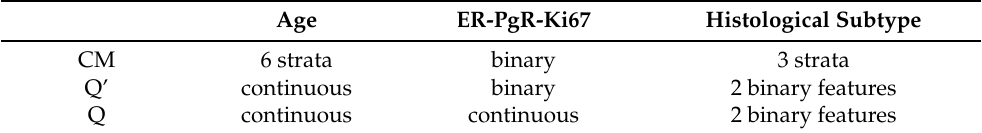
Table 2. Sampled data set stratifications for CancerMath CM and quantum-inspired classifiers Q,